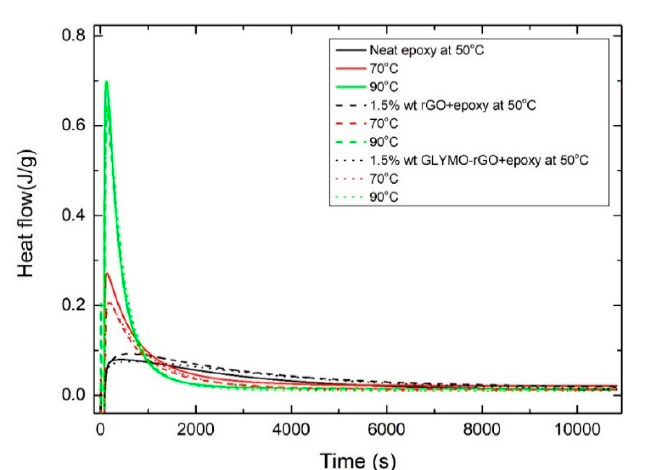
Figure 8. Isothermal DSC thermograms for neat epoxy and nanocomposites containing 1.5 wt% rGO at different temperatures.